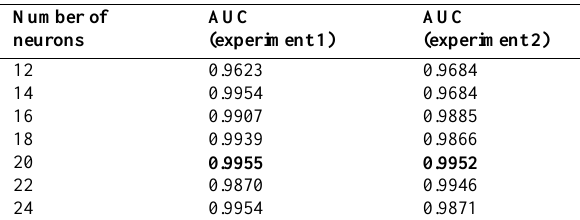
Table 4. AUC for FFNN in which number of neurons in hidden layer vary from 12 to